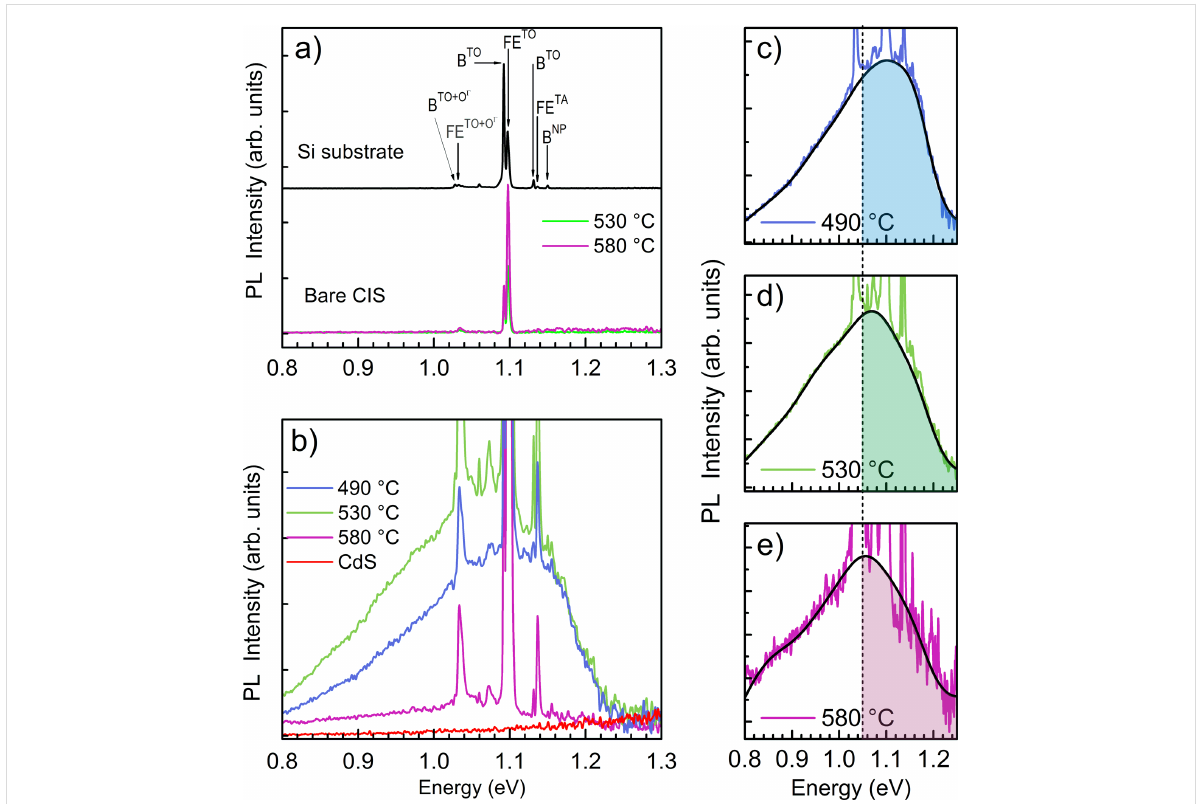
Figure 4: (a) PL spectra measured at 7 K and with an excitation power of 104 mW of a Si substrate and the bare CIS nanodots samples. (b) PL Spec- tra of the same CIS samples (in (a)) covered with CdS, measured at the same temperature and with an excitation power of 220 mW. A PL spectrum of a CdS layer deposited on top of a glass covered with a Mo layer is shown for comparison. (c), (d), and (e) show, for each sample, the broad band CIS-related emission superimposed on the Si-related peaks. The dashed line indicates the bulk bandgap of CIS at low